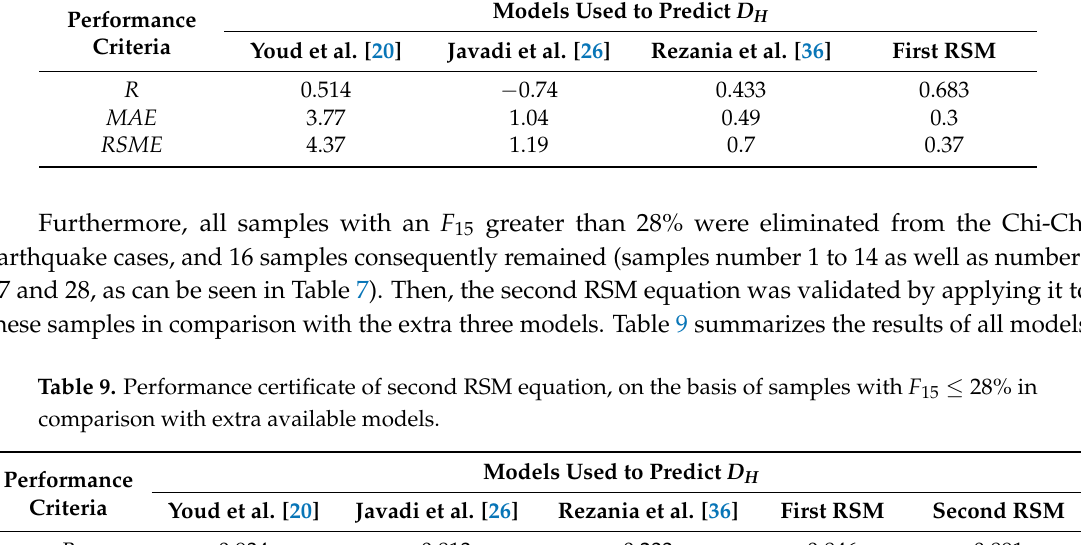
Table 8. Performance certificate of first RSM equation in comparison with extra available models.